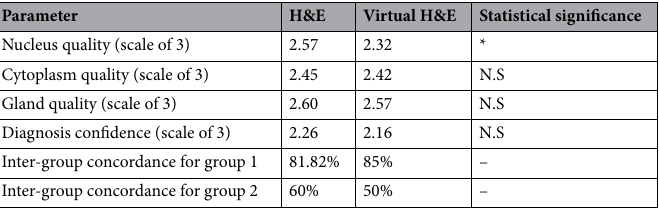
Table 1. Comparison of translated UV images with H&E scans. N.S.: Not statistically significant. * p <